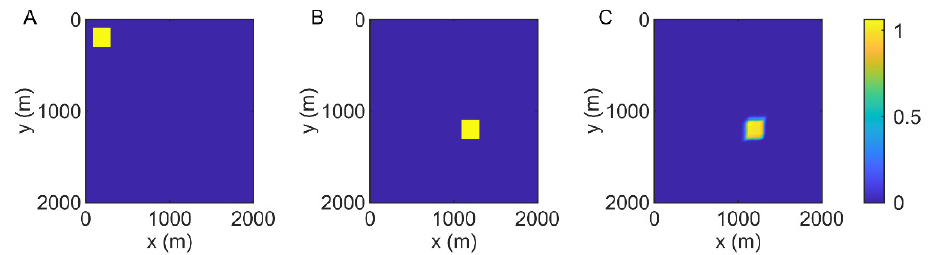
Figure 6. Simulations using different numerical schemes: ( A ) the original location, ( B ) the result in the Lagrangian description, and ( C ) the result in the Eulerian description.